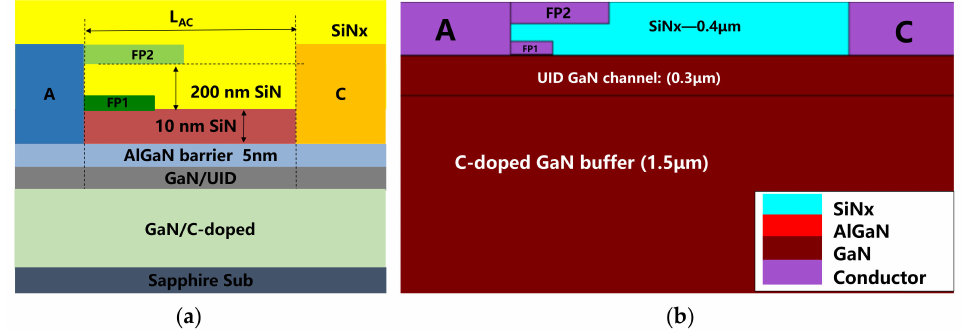
Figure 1. ( a ) Schematic of the Schottky barrier diode (SBD) for its measurement. ( b ) Schematic of the SBD for its